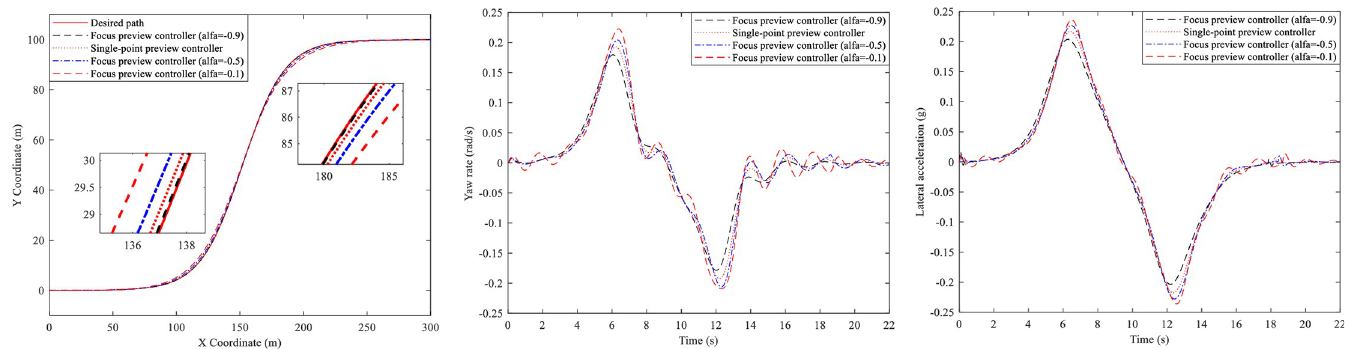
Fig 5. Single lane change simulation. (A) Trajectory curves. (B) Yaw rate curves. (C) Lateral acceleration curves.